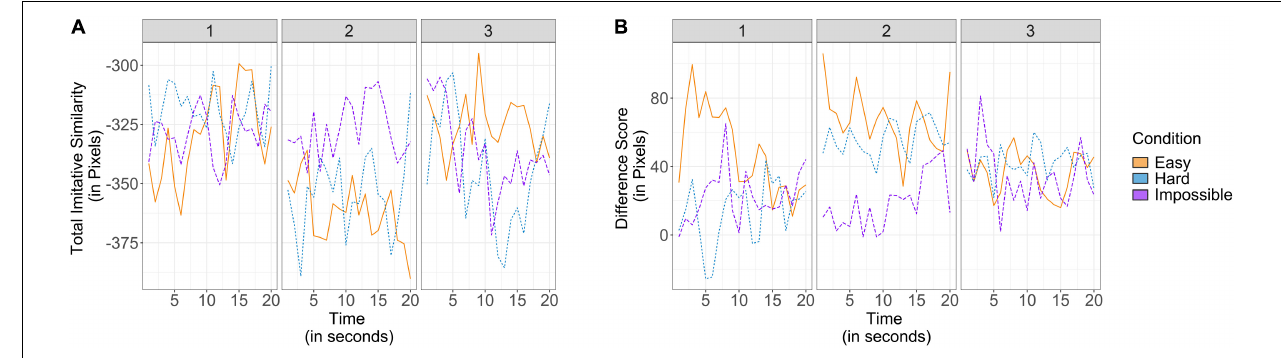
FIGURE 2 | Imitative similarity plotted as (A) an additive score combining variation from imitation in the x - and y -axes and (B) a difference score subtracting variation from imitation in the y -axis from the x -axis. Each graph is plotted by time, divided by condition and trial number. In the case of the additive score, greater values represent greater imitation, while in the case of the difference score, greater values represent greater variation in the x -axis relative to the y